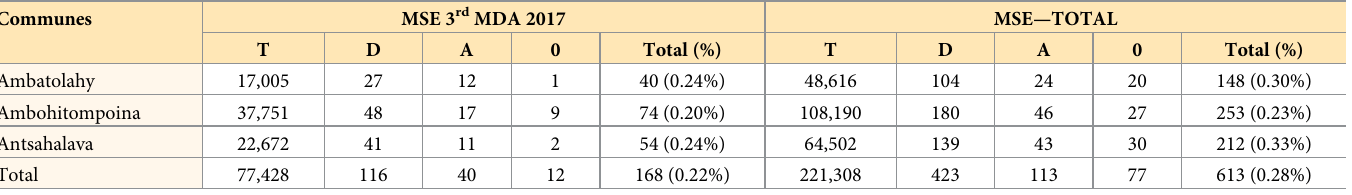
Table 3. Minor side effects (MSE) recorded during a 3-year MDA pilot project for taeniasis control in Madagascar using praziquantel 10mg/kg in patients > 5 years of age (continued from Table 2).